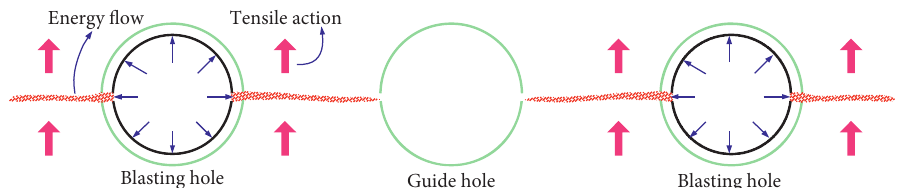
Figure 18: Sketch of the “blasting-guiding-blasting” pattern.